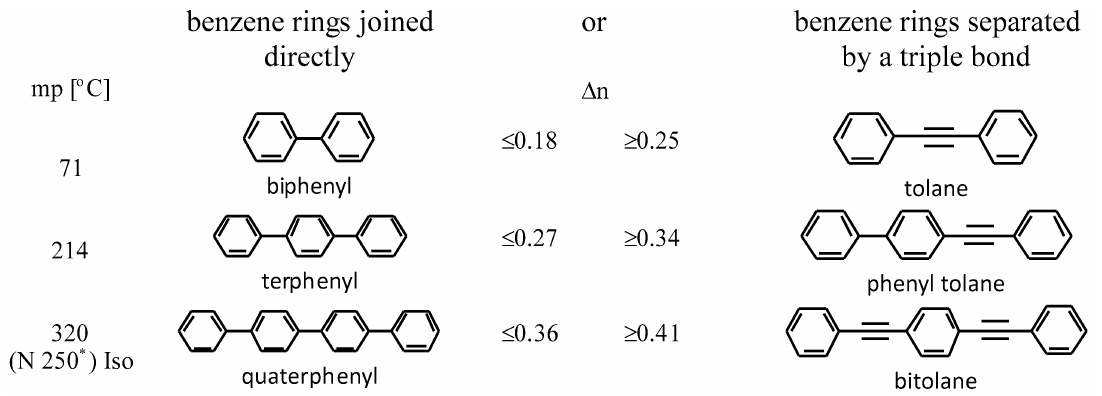
Figure 3. The most useful rigid cores for designing high birefringence liquid crystal molecules. Input to the birefringence: benzene ring ~0.09, triple bond ~0.07.